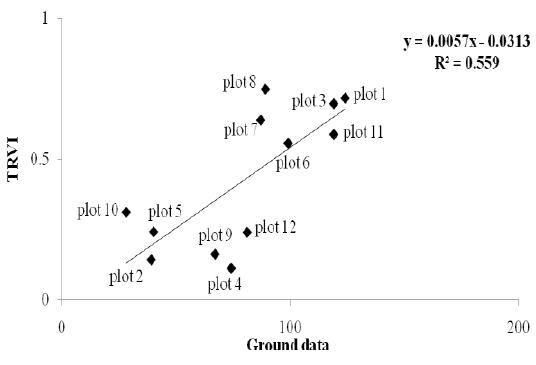
Figure 8. The relationship between juniper tree density and TRVI vegetation